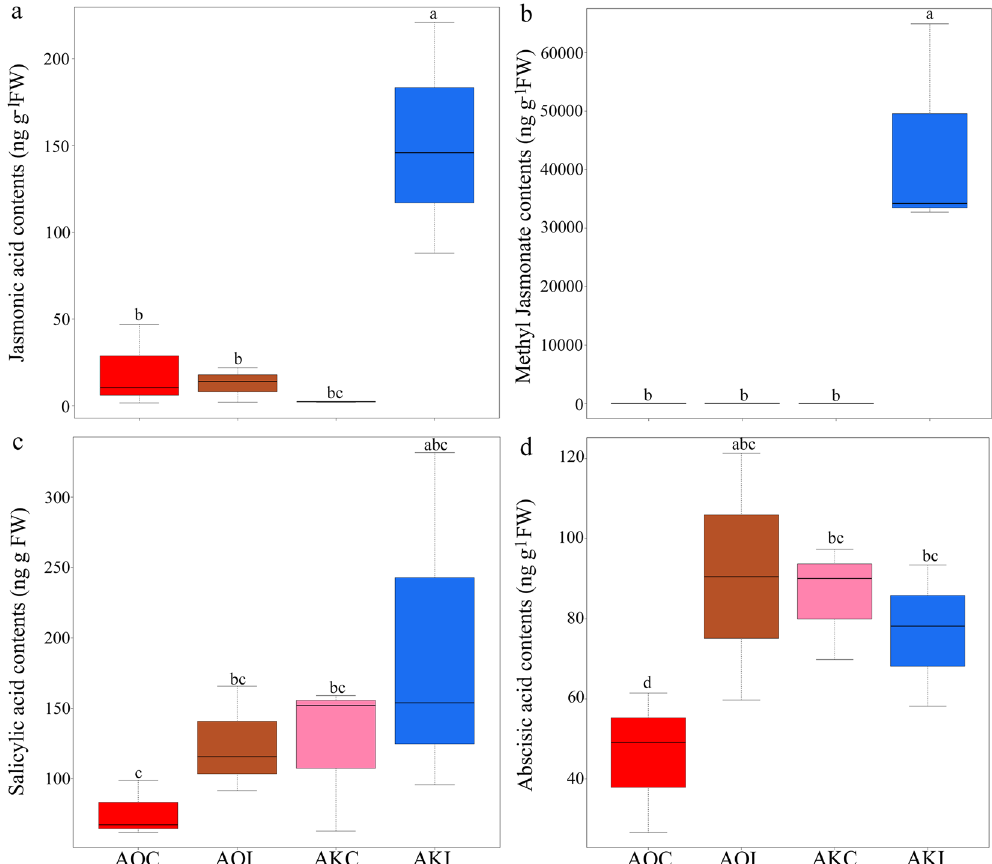
Figure 7. Box plot diagram showing the changes in ( a ) jasmonic acid (JA), ( b ) methyl jasmonate (MeJA), ( c ) salicylic acid (SA) and ( d ) abscisic acid (ABA) levels (ng g − 1 FW) in Asparagus kiusianus inoculated with Phomopsis asparagi (AKI) and their relative levels in A . officinalis inoculated with P . asparagi (AOI). A . kiusianus and A . officinalis treated with sterile distilled water (AOC and AKC, respectively) served as controls. Values represent the maximum, third quartile, median, first quartile and minimum of three independent replicates ( n = 3). Different letters indicate statistically significant difference at P < 0.05 according to Tukey’s honest significant difference (HSD) post hoc